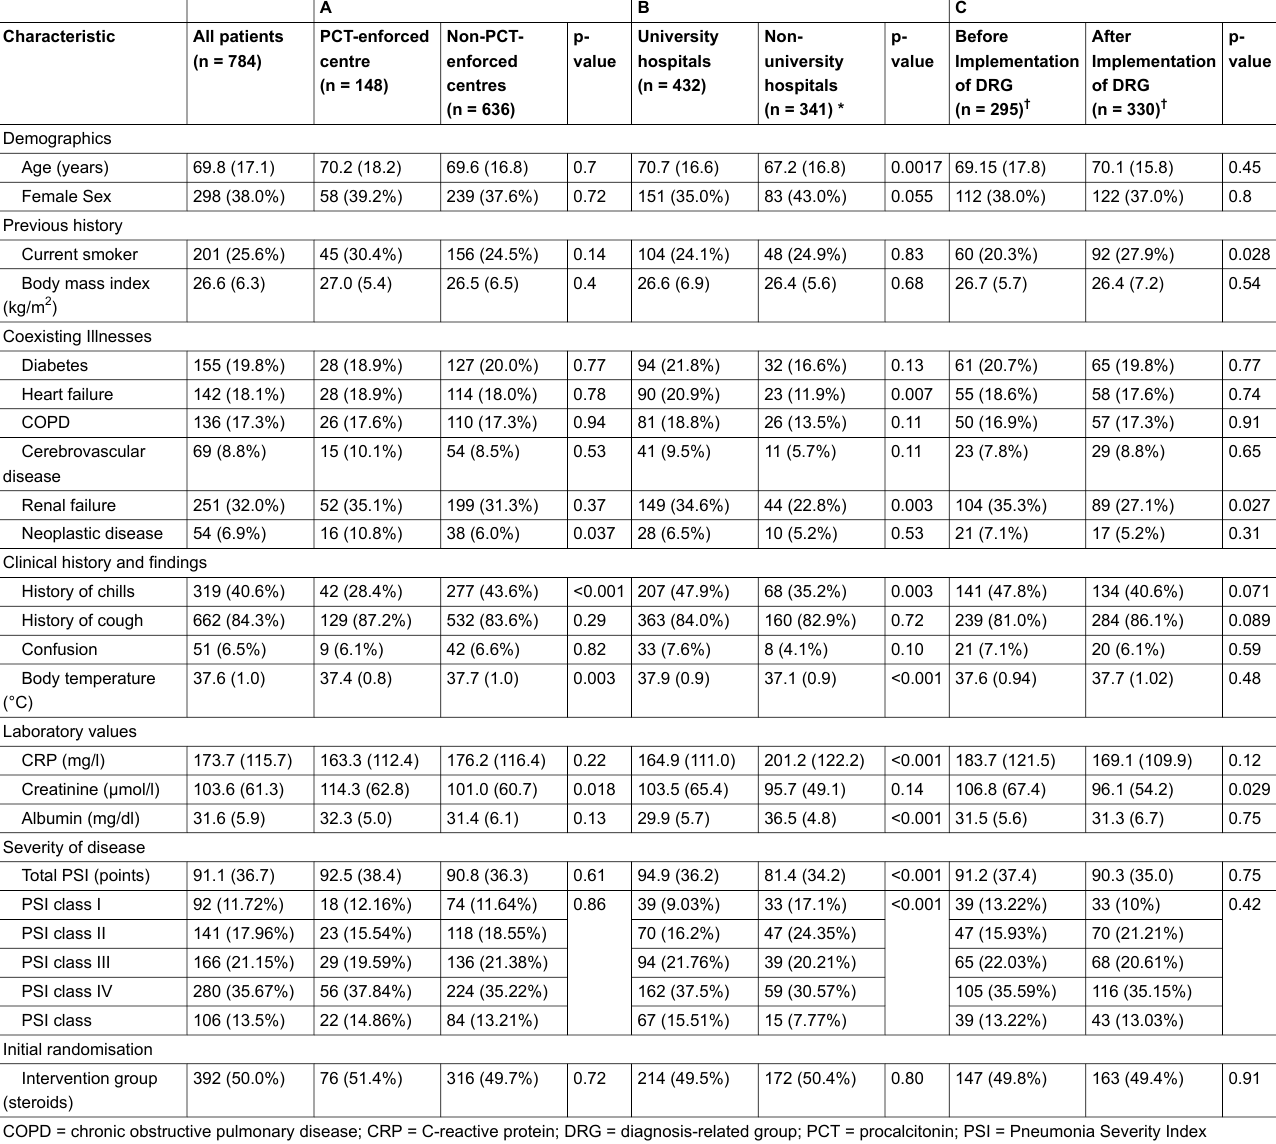
Table 1: Baseline characteristics of patients according to: (A) use of antibiotic stewardship protocol including procalcitonin; (B) type of institution (university vs non- university); (C) historical time period in relation to the introduction of DRG reimbursement. A B C